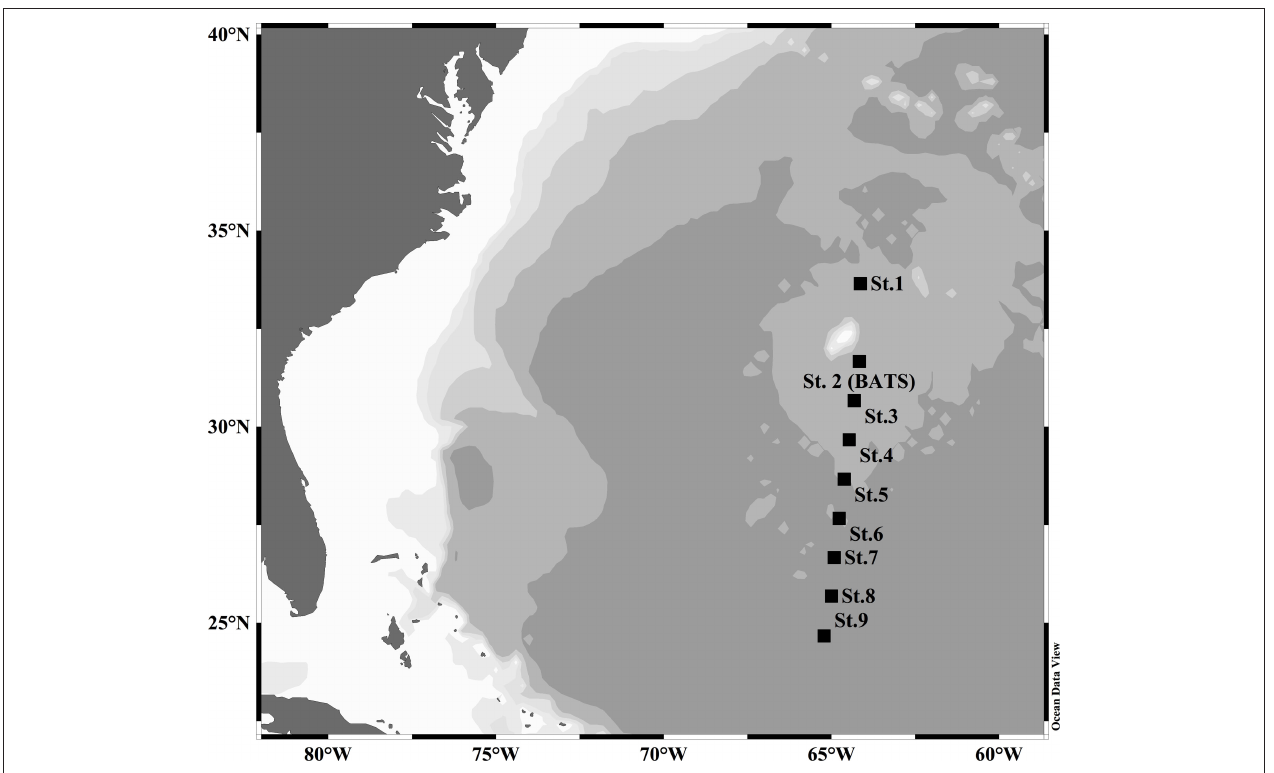
FIgure 1 | Map of Sargasso Sea stations sampled during May and October